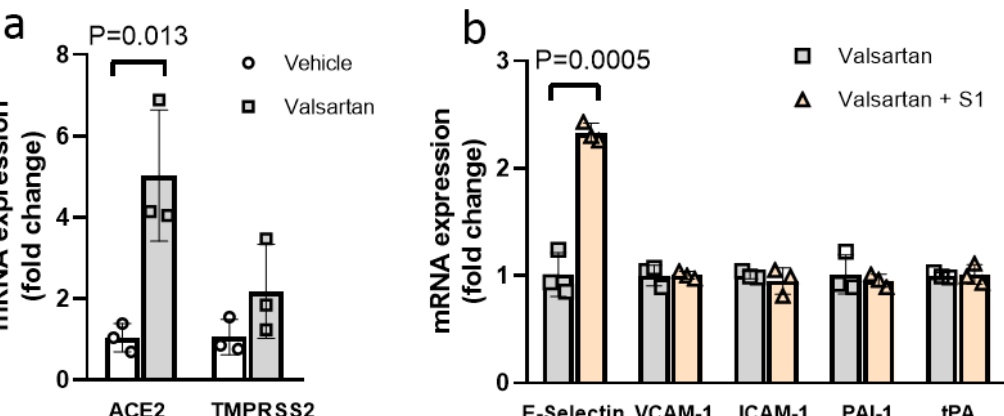
Figure 4. Angiotensin receptor blockade did not exacerbate S1-mediated EC injury in ECs. ( a ) Angiotensin receptor blockade with valsartan (10 mM) significantly increased in vitro EC ACE2 transcript expression without affecting TMPRSS2 expression as compared to the vehicle control. ( b ) In the presence of valsartan, S1 (25 nM) significantly increased the transcript expression of cell surface adhesion molecule E-Selectin, while VCAM-1 and ICAM-1 were not affected. In vitro EC transcript expression of the anti-fibrinolytic and fibrinolytic genes PAI-1 and tPA, respectively, were not affected by S1 exposure in the presence of valsartan. n = 3 in all groups. Data were analyzed by two-sided unpaired t -test. p < 0.05 was defined to be statistically significant. All data are expressed as mean ± s.d.